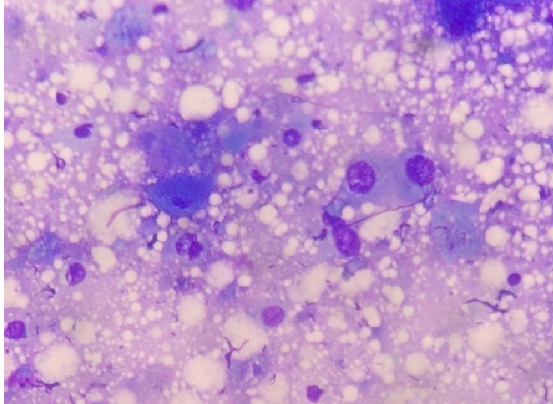
Fig 2: Smear showing malignant squamous cell in metastatic squamous cell carcinoma.